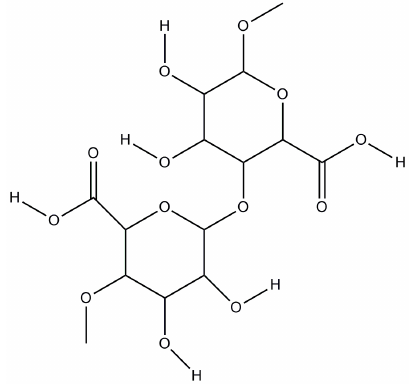
Figure 1. Alginic acid-structural formula.